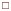
Circular dichroism (CD) experiments in the visible spectral region.(A) Vis-CD spectra of WT (■), E194Q (□) and 2Glu (□) in water, pH 7.0. The spectra of E9Q, E74Q and E204Q single mutants (not shown) are identical with those of E194Q. The CD spectra of WT and of all single mutants reveal the well-known biphasic bands (535/600 nm) of the retinal chromophore, while the multiple mutants show only one band (at about 468 nm). (B) Representative Vis–CD spectra of 3Glu in the presence of increasing (by 0.2 M) concentrations of KCl (pH 6.0). Arrows indicate the direction of spectral changes with KCl increases. Upon addition of KCl, the monophasic spectrum is converted to a biphasic, indicative for conformational changes in the retinal binding pocket.